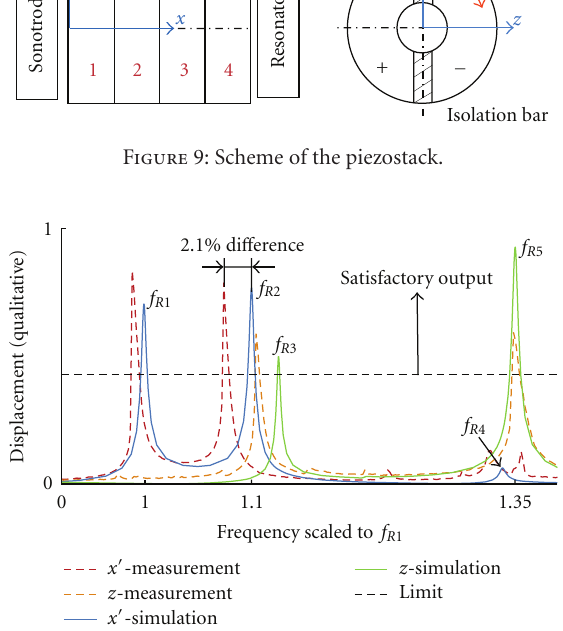
Figure 10: Experimental and simulated displacement of one new scaler.